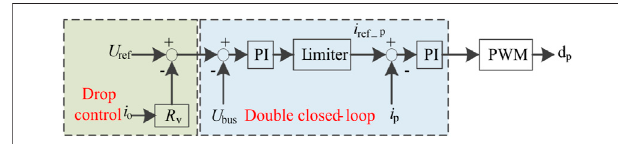
FIGURE 4 | The control structure diagram of High-Power Battery.